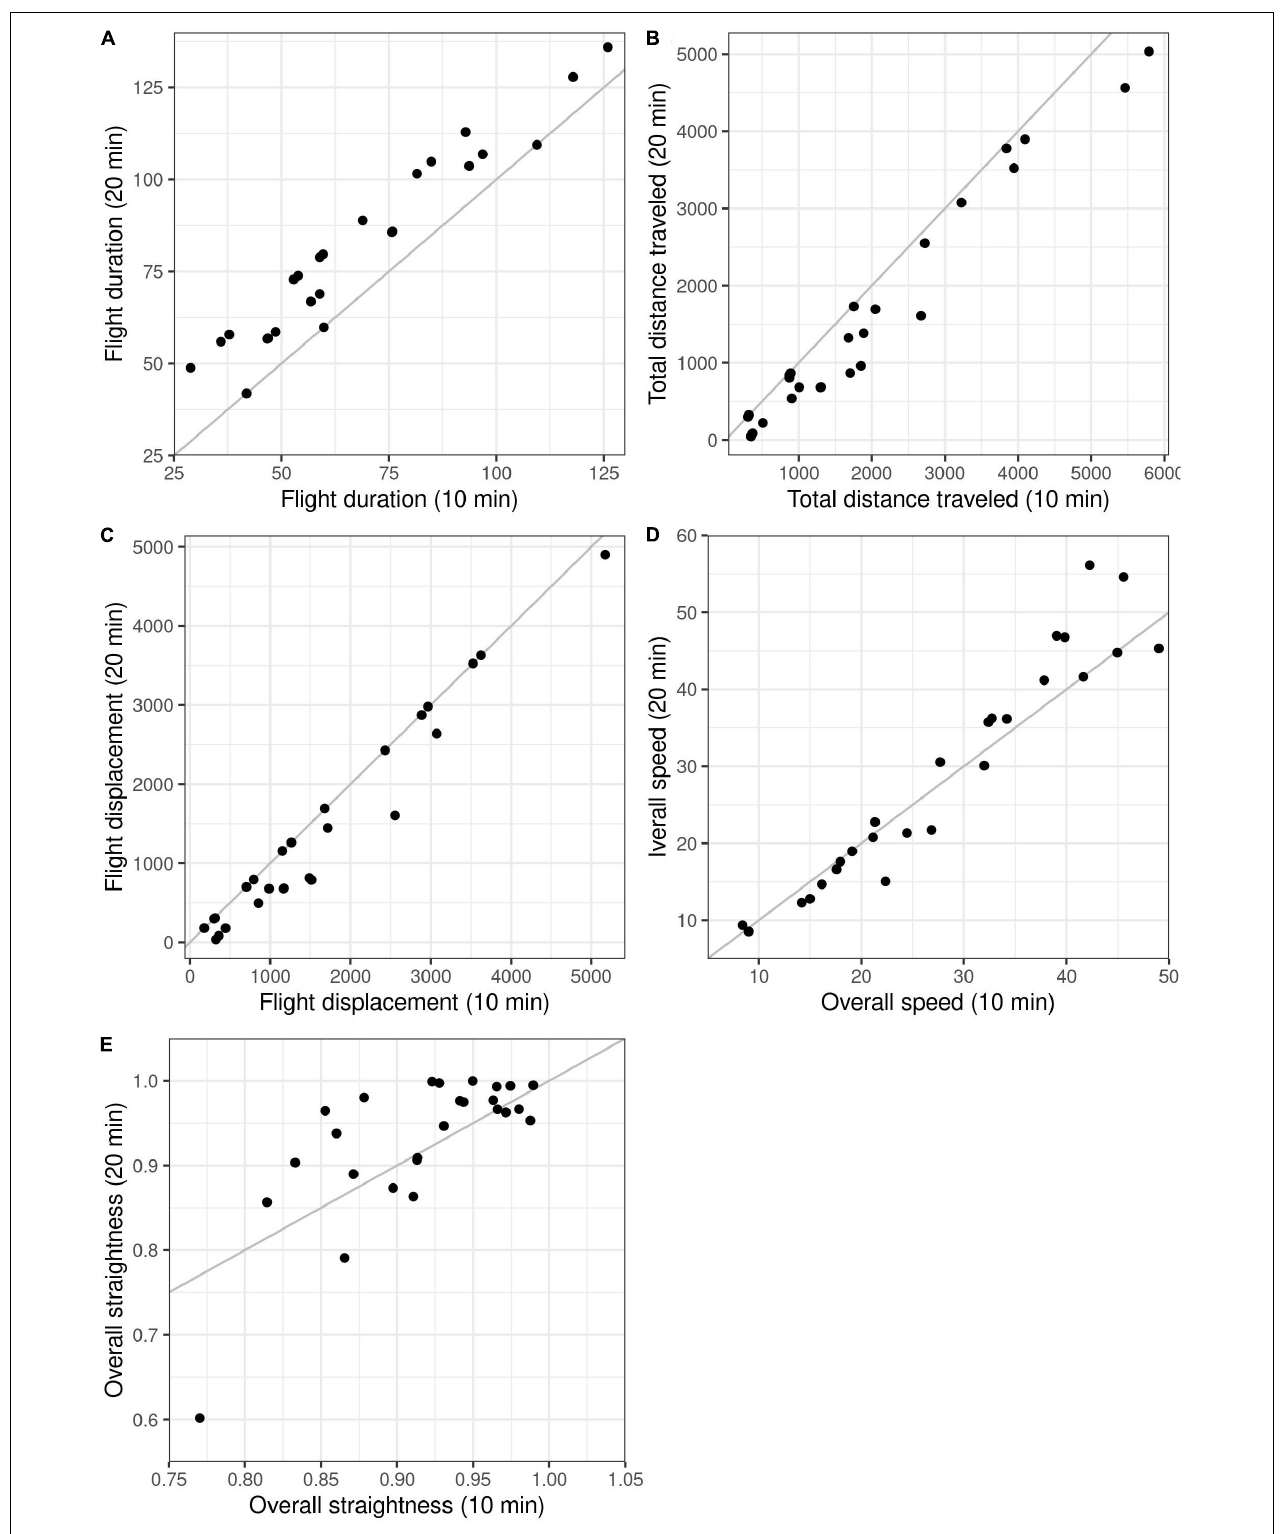
FIGURE 6 | Comparison of five different wolf response variables (A–E) from experimental human approach trials, calculated from GPS data at 10- and 20-min resolution. Variables were calculated for the duration of the flight, i.e., from flight initiation to resettling. Each dot represents one wolf-human interaction. Dots on the gray lines indicate interactions in which the temporal resolutions gave identical